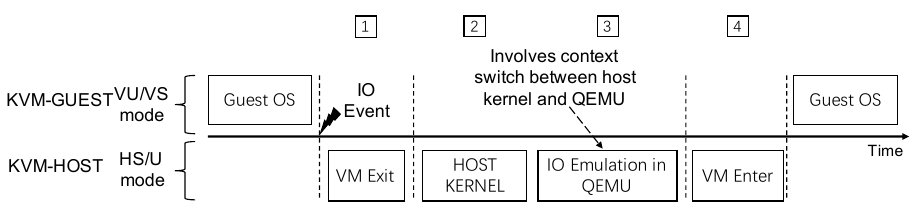
Figure 10. KVM IO emulation